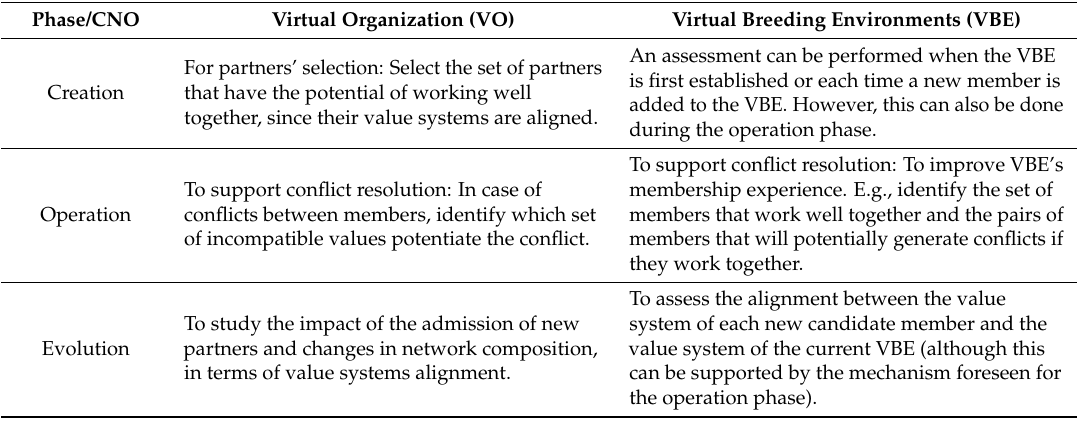
Table 3. Potential application of Value System Alignment Analysis in each life-cycle